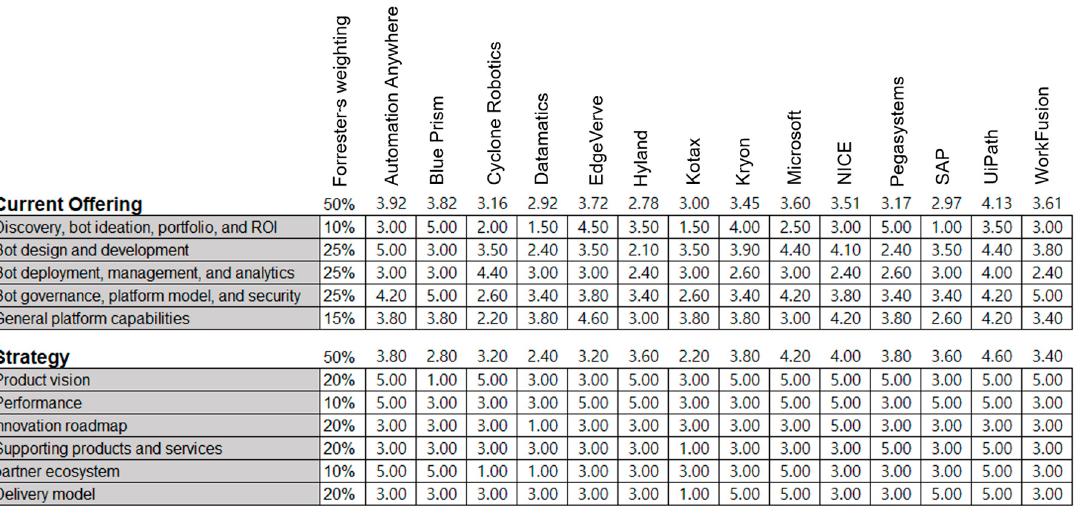
Table 1. Evaluation factors by dimensional classification of RPA product functions according to the US Federal RPA Community of Practice. Adaptation based on Ref. [25]. Dimensional Classification